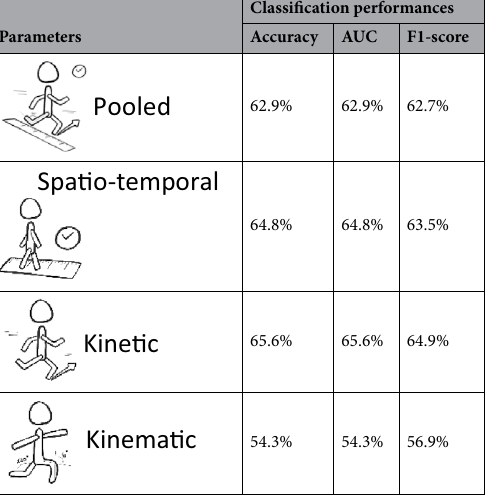
Table 3. Performance metrics (Accuracy, AUC, and F1-score) for the pooled and unpacked (i.e., spatio- temporal; kinetic; kinematic) subsets of parameters. For each performance metric index, the p-value computed using a permutation test resulted statistically significant (p < 0.05). AUC: Area under the